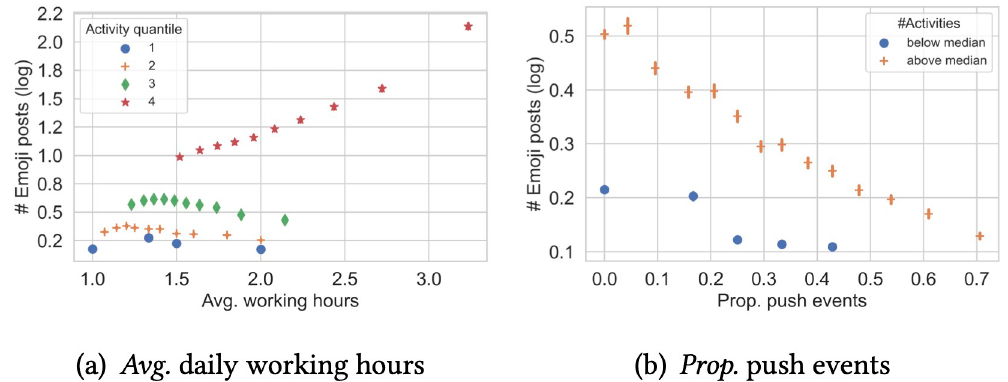
Fig 2. Working status of a developer is related to the number of emoji posts. (a): Avg . daily working hours. (b): Prop . push events.